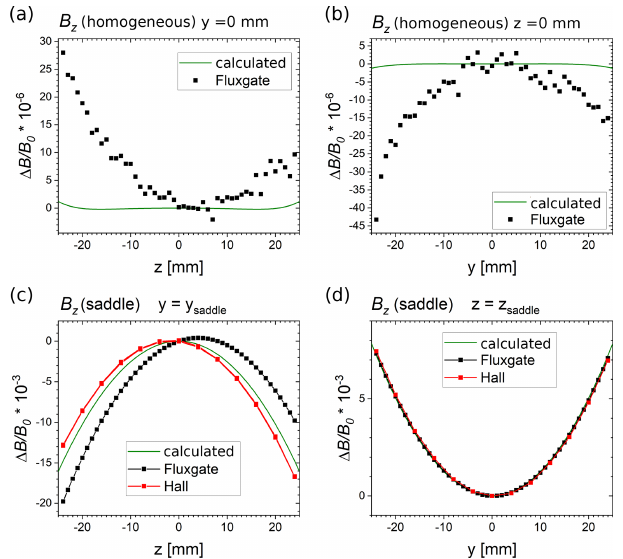
Figure 4. Direct comparison of experimental and theoretical re- sults for homogeneous (a, b) and saddle field configuration (c, d) for selected data points as marked in Fig. 3a, and (c) by dashed and dotted lines. The experimental data were obtained by fluxgate measurements, and for the saddle field configuration in (c) and (d) , complemented by Hall sensor